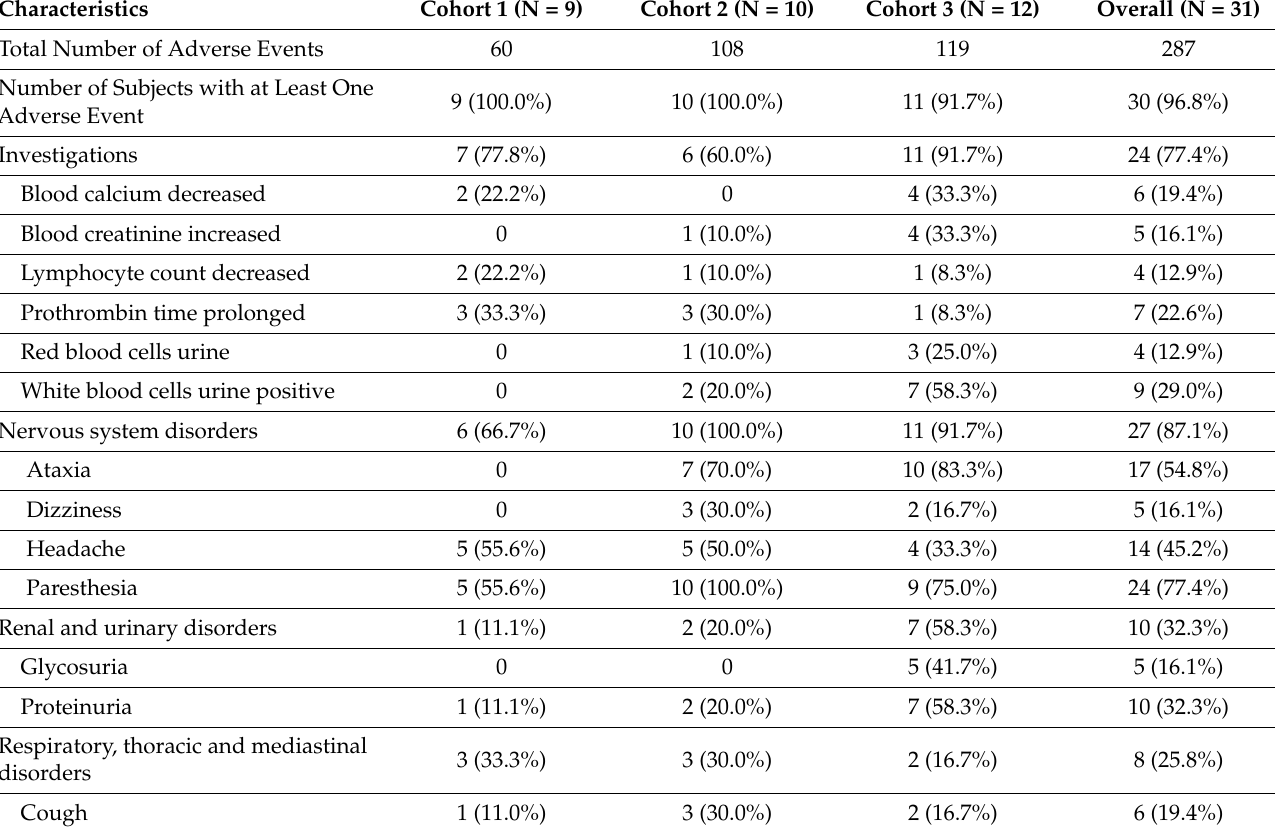
Table 3. Treatment-emergent adverse events ≥ 10% overall by preferred term—safety